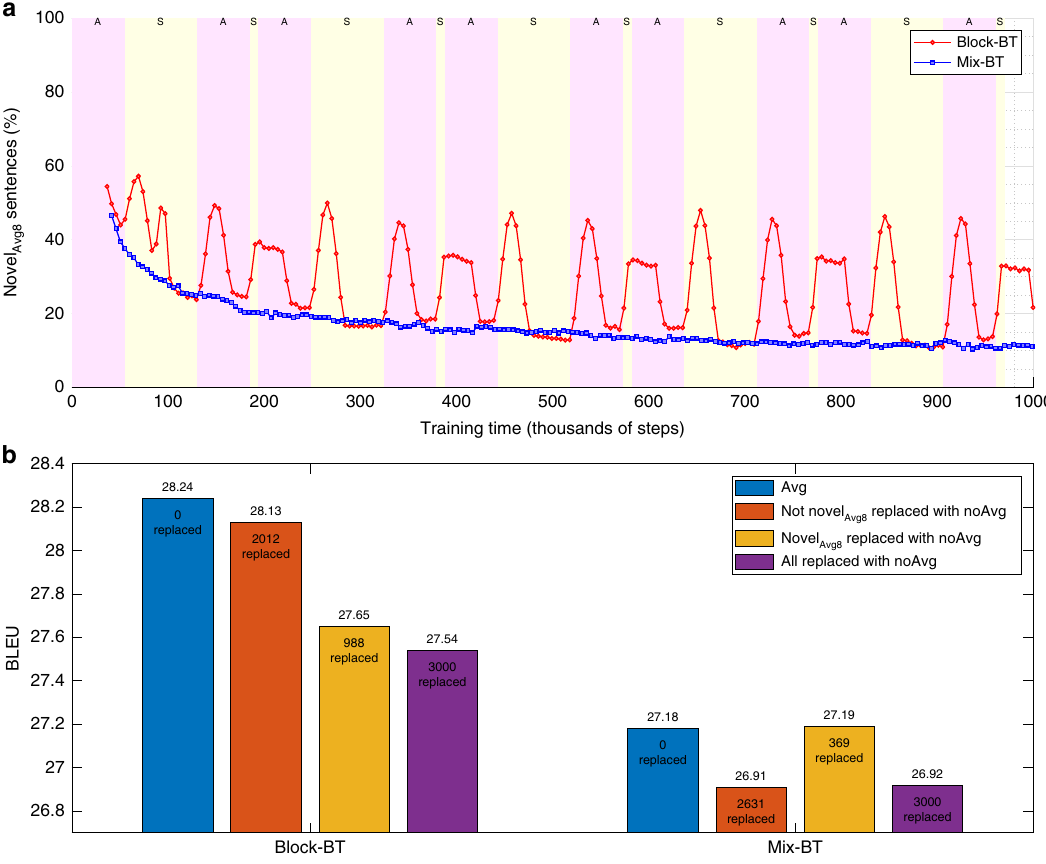
Fig. 8 Synergy between block-BT and checkpoint averaging through novel Avg8 translations. a Percentage of WMT13 newstest sentences with novel Avg8 translation (not seen in the previous eight checkpoints without averaging) over time, shown separately for block-BT (red) and mix-BT (blue). The checkpoints trained in AUTH blocks are denoted by magenta background and letter A, while the SYNTH blocks are shown in yellow background and letter S. b Evaluation of translation quality by BLEU on WMT13 newstest set for four different versions of block-BT (left) and mix-BT (right), exploring the importance of novel Avg8 sentences created by checkpoint averaging. The general approach is to take the best system using checkpoint averaging (Avg), and substitute translations of novel Avg8 and not-novel Avg8 sentences with translations produced by the best system without checkpoint averaging (noAvg), observing the effect on BLEU. In blue is the BLEU achieved by the model with checkpoint averaging, while in purple is the BLEU achieved by the model without checkpoint averaging. In red is the BLEU of a system, which used checkpoint averaging, but where the translations that are not novel Avg8 were replaced by the translations produced by the system without checkpoint averaging. Conversely, yellow bars show BLEU of a system, which uses checkpoint averaging, but where the novel Avg8 translations were replaced by the version without checkpoint